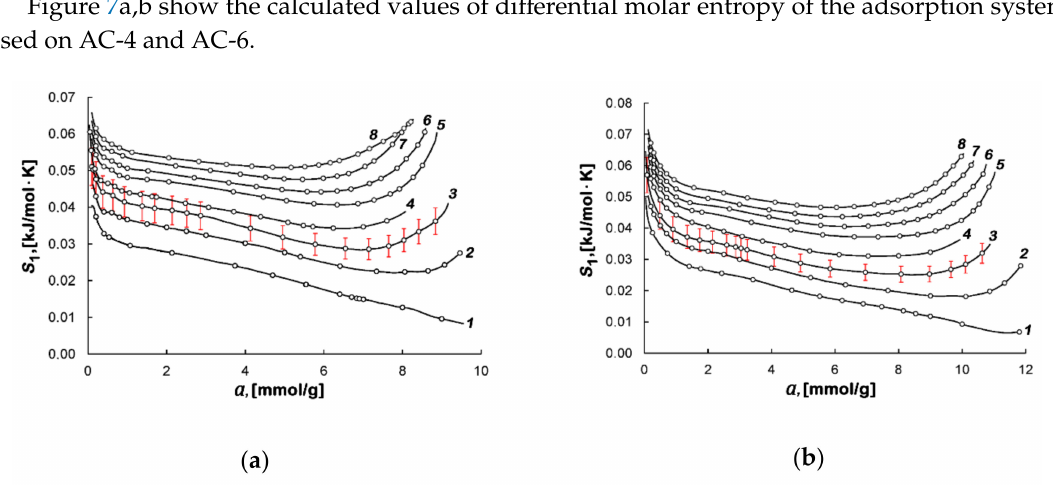
Figure 7. The di ff erential molar entropy of the methane-AC-4 ( a ) and methane-AC-6 ( b ) adsorption systems versus the values of methane adsorption at temperatures, K: 178.00 ( 1 ), 216.00 ( 2 ), 243.00 ( 3 ), 273.15 ( 4 ), 300.00 ( 5 ), 320.00 (6), 340.00 (7), and 360.00 ( 8 ). Symbols indicate the experimental data; solid lines are the smoothing spline curves. The error bar is